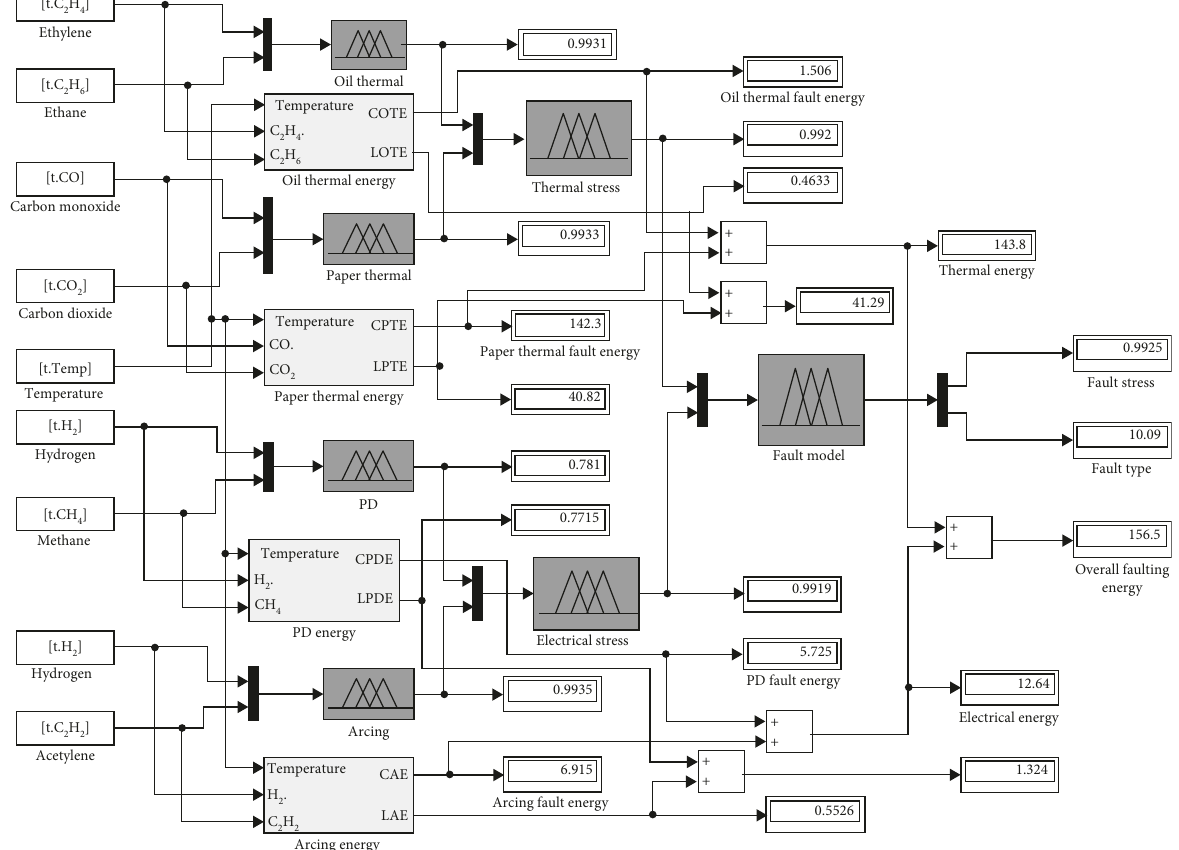
Figure 9: Proposed fault and severity